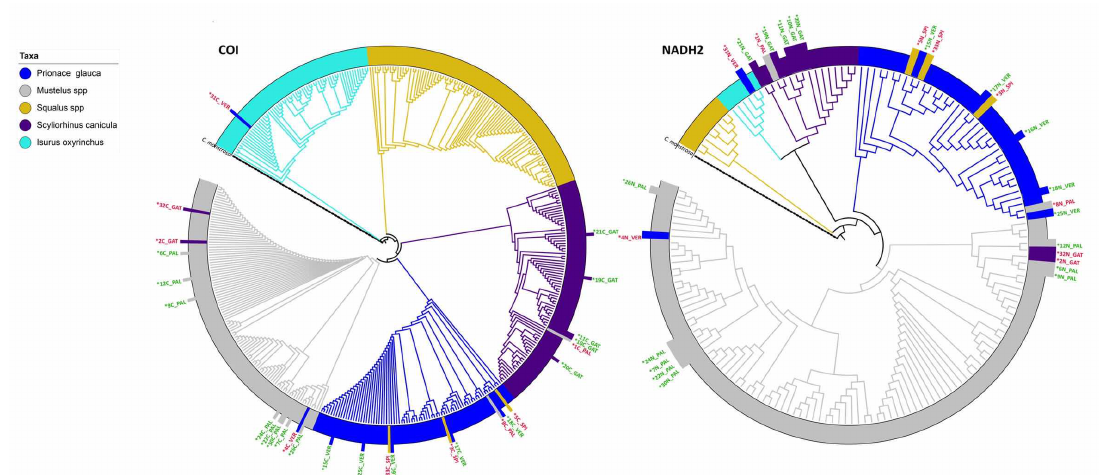
Figure 2. Maximum likelihood trees for the two markers including the reference sequences, outgroup (black dash line) and the specimens to identify. Leaves corresponding to the specimens (taller bars) have the color corresponding to that of the original labels while the names are colored based on the congruence (green) or incongruence (red) between the original label and tree placement.